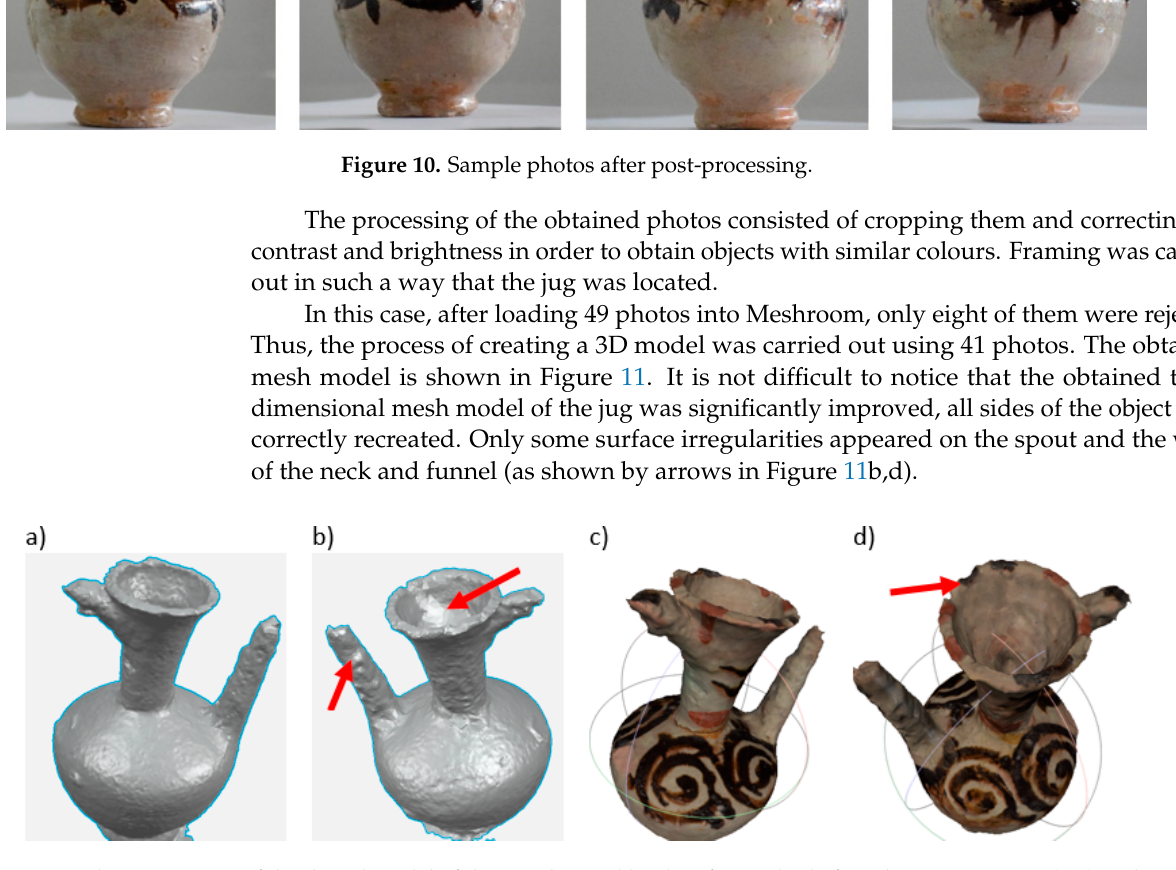
Figure 11. The appearance of the digital model of the jug obtained by the SfM method after photo processing: ( a , b ) without texture—page one and two, ( c , d ) with texture—page one and two.